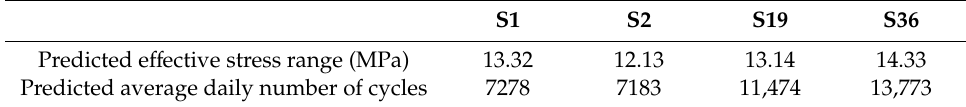
Table 9. Predicted e ff ective stress range and average daily number of